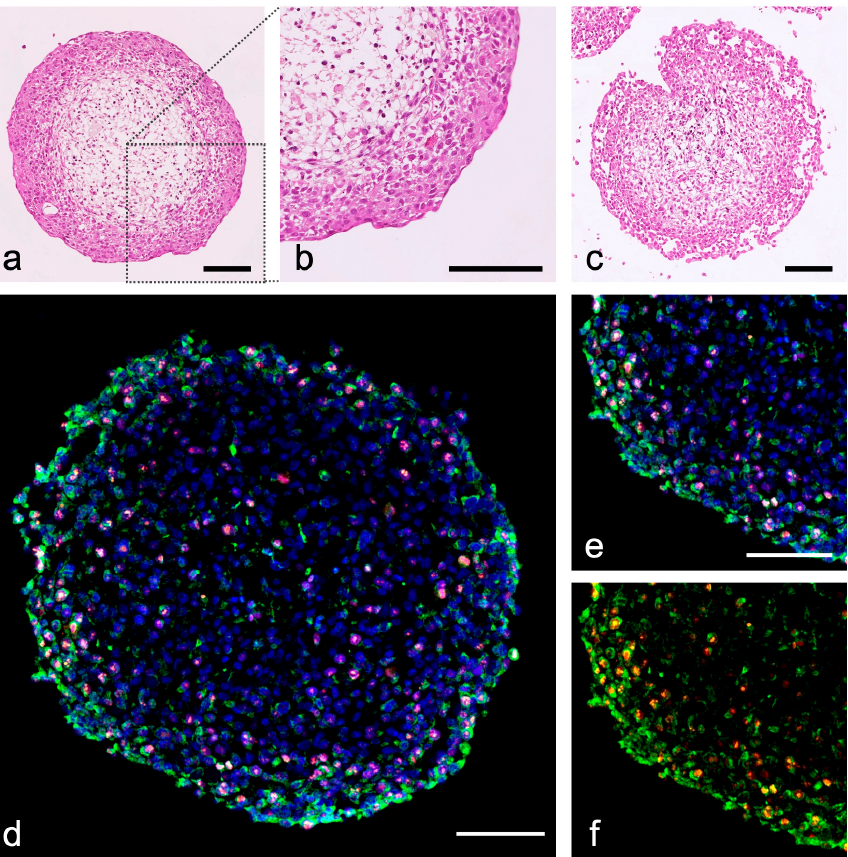
Figure 4. Urinary bladder tumor organoids from RT-112 (initial tumor grade 2) and T-24 (grade 3), HBF and HBSMC. ( a – c ) Hematoxylin-eosin staining (HE) of human BCa organoids; ( a , b ) RT-112 organoids show a clear urothelial stratification, T-24 organoids show a loose structure ( c ); ( d – f ) immunohistochemical staining of cytokeratin (green, CKPAN), Ki-67 (orange), nuclei are stained with DAPI (blue); ( e , f ) detail of ( d ) showing T-24 cells by their cytokeratin expression in the organoid (green, CKPAN); T-24 BCa cells show a high proliferation index (red, Ki-67); purple by overlay with nuclei); scale bar: 100 μ m; antibodies used (Table S1).